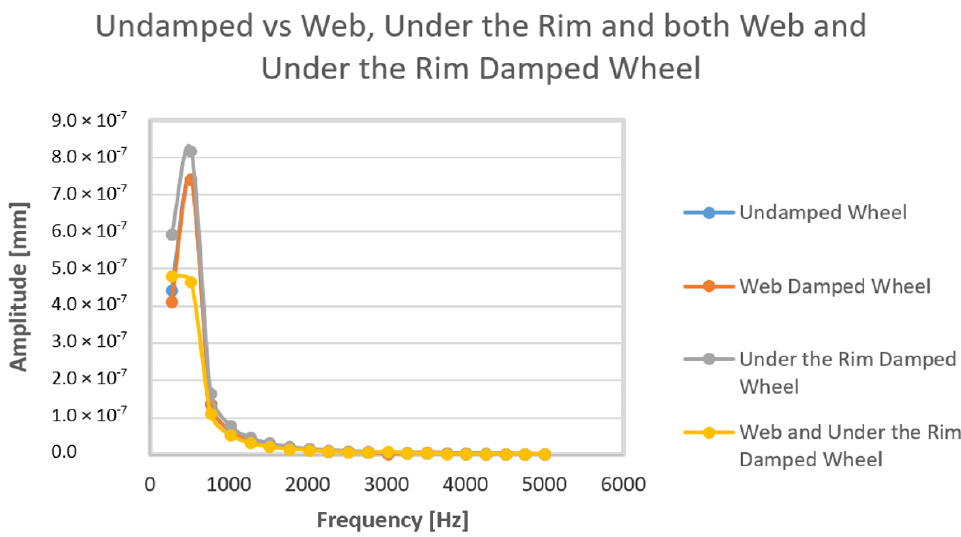
Figure 21. Comparison of the undamped wheel during lateral excitation with the web damped, the area under the rim damped and both the web and area under the rim damped at the same